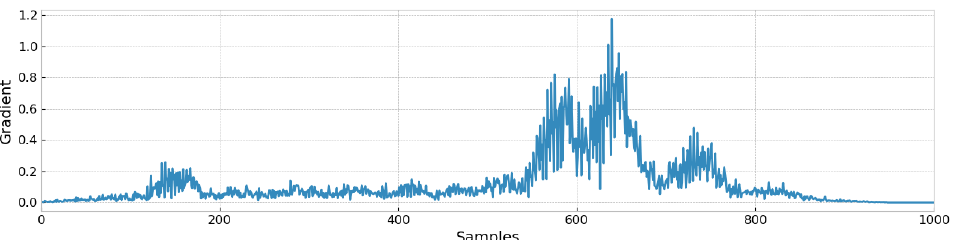
Figure 12: Input gradient visualization for the cswap-pointer